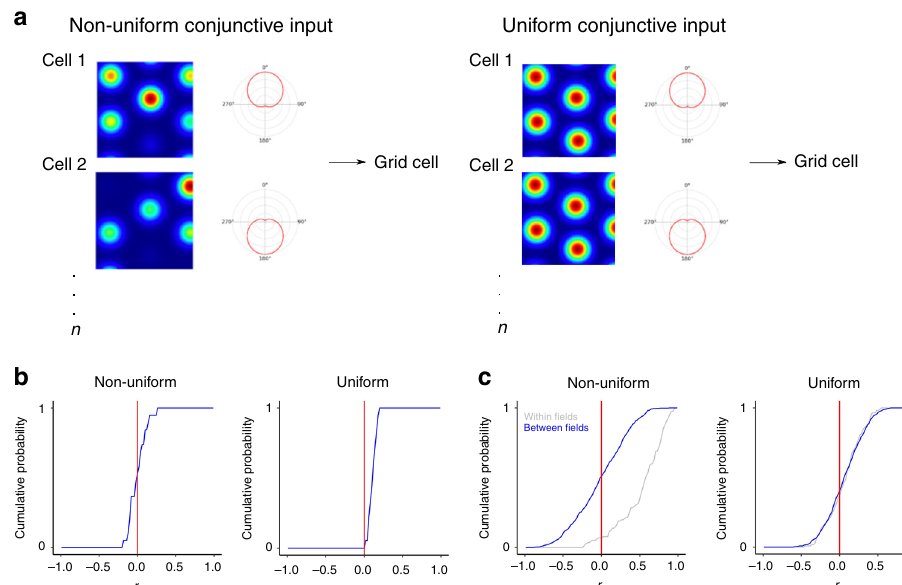
Fig. 8 Location-dependent fi ring emerges when conjunctive cell activity is spatially non-uniform. a Schematic of uniform and non-uniform conjunctive cell input models. b Distribution of average Pearson coef fi cients from correlation between fi elds of simulated grid cells calculated as in Fig. 4b. The distribution of correlation coef fi cients differed between uniform and non-uniform conjunctive input models ( p = 3.99 × 10 − 6 , D = 0.21, two-sided Kolmogorov – Smirnov test). c Correlations between fi ring rate histograms for the same fi eld (grey) and between different fi elds of the same cell (blue) generated as in Fig. 4. The between- and within- fi eld distributions differed from one another for the non-uniform model ( p = 2.2 × 10 − 16 , D = 0.62, two- sided Kolmogorov – Smirnov test) but not for the uniform model ( p = 0.14, D = 0.13). The half-session between fi eld distributions differed between the non- uniform and uniform models ( p = 7.1 × 10 − 8 , D = 0.17, KS